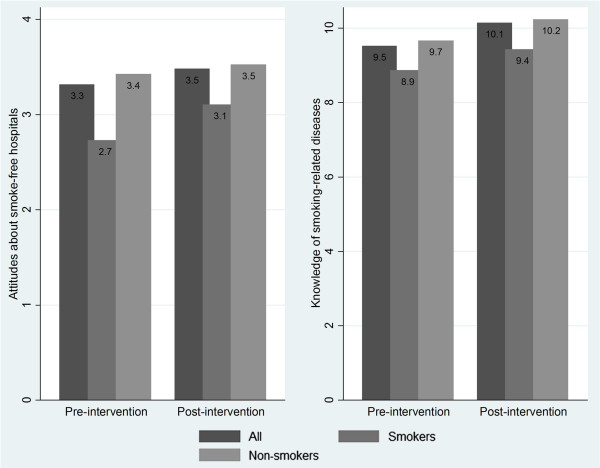
CATC intervention.